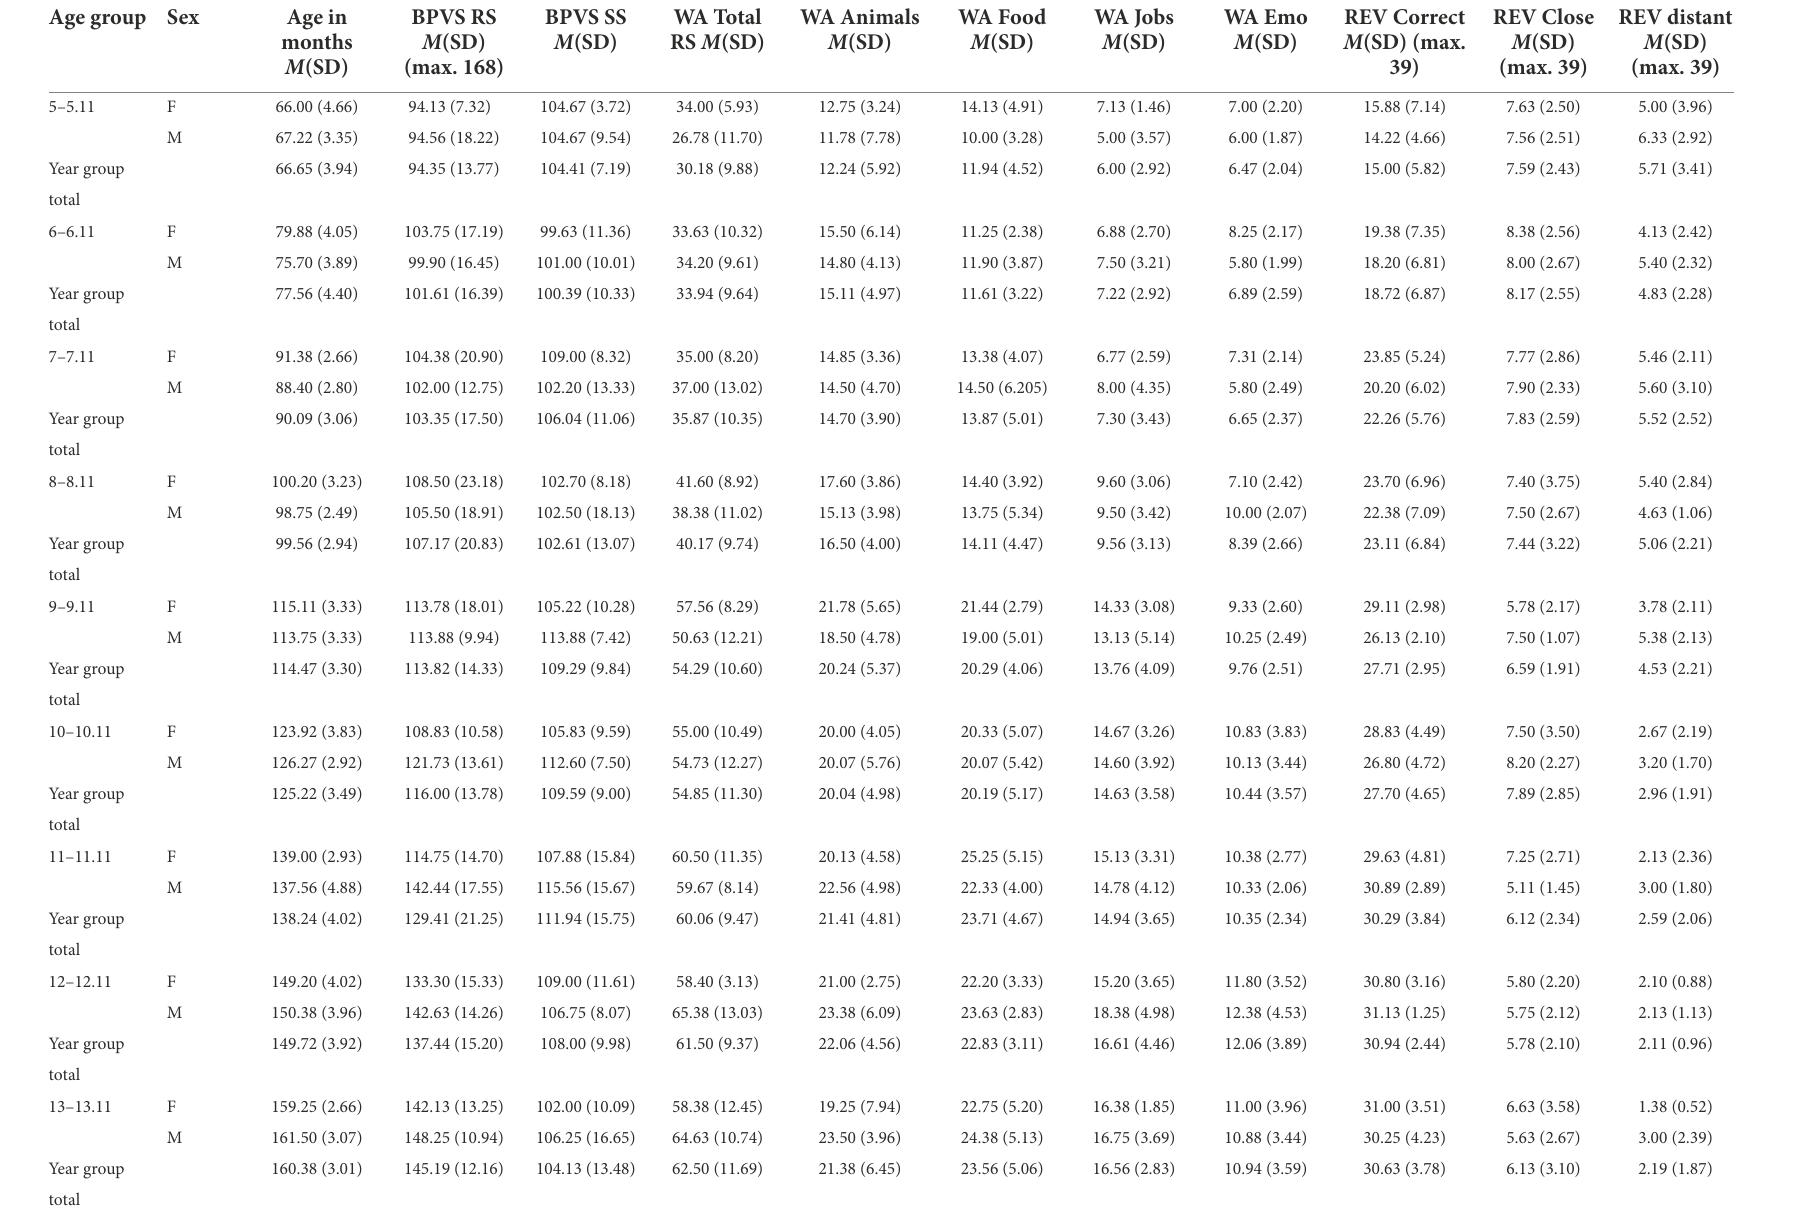
TABLE 2 Showing total correct raw scores for BPVS, WA, WA sub-scores, and for The EVER Measure (WA:Emo and REV) and standard scores for